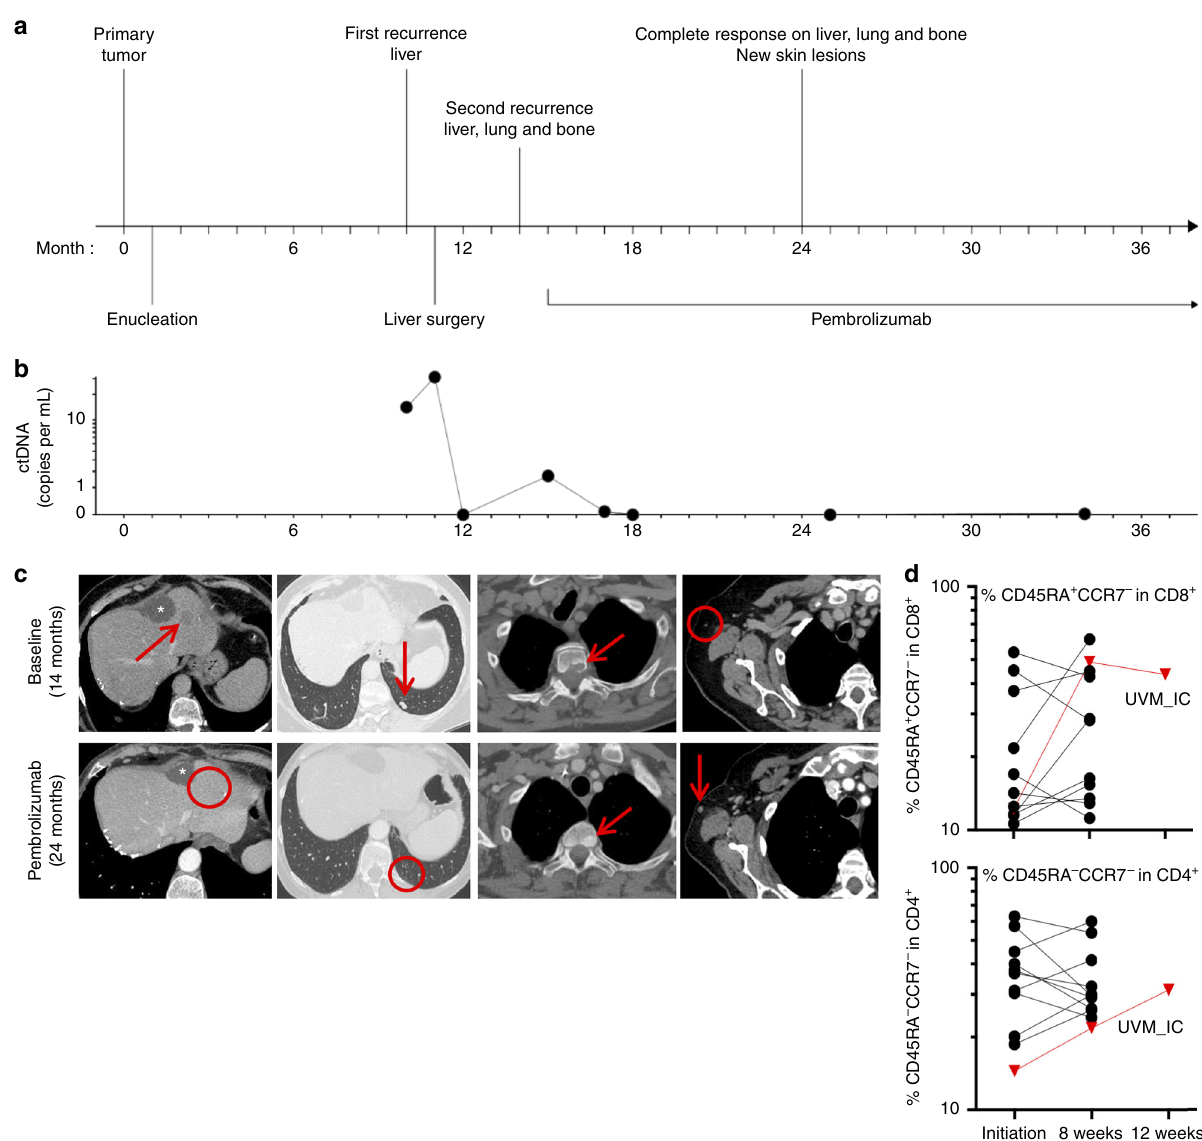
Fig. 1 Disease course and immune response in patient UVM_IC. a Disease course since diagnosis. b Evolution of the GNAQ Q209L mutation in circulating tumor DNA (ctDNA). c Computed tomography images at second relapse (14 months) and after 10 months of pembrolizumab (24 months). Arrows and circles show locations of metastases; asterisks indicate a simple hepatic cyst. d Proportions of blood effector memory CCR7 − /CD45RA − /CD4 +